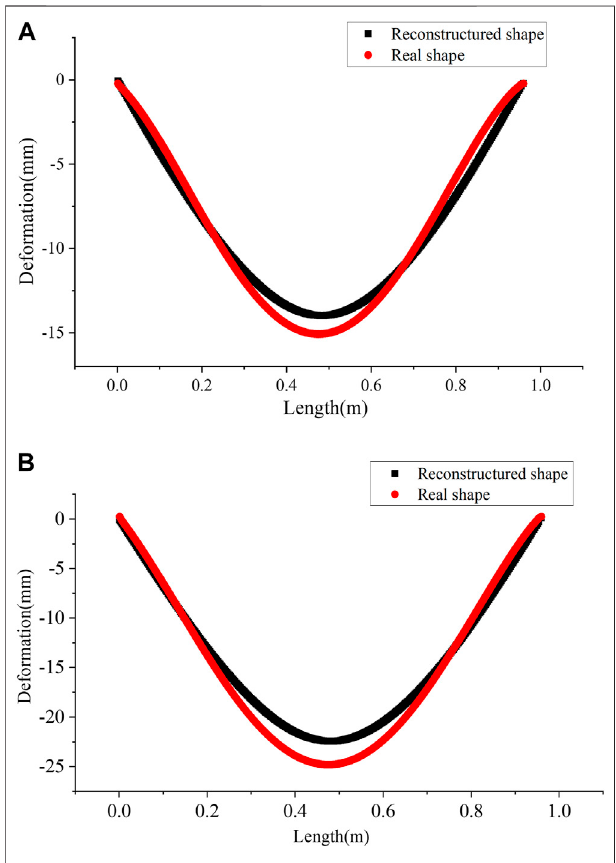
FIGURE 6 | Pipe shape reconstructed by the axial strain distribution. (A) 15 mm deformation. (B) 25 mm